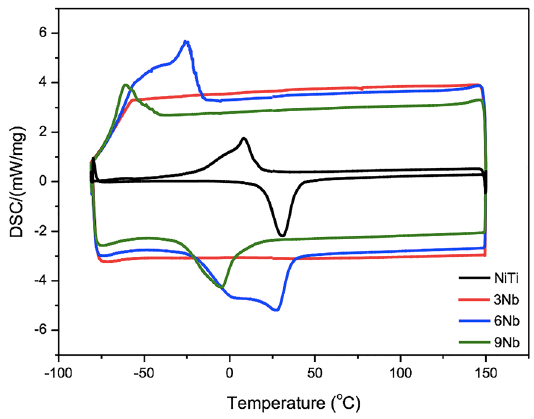
Figure 5. Resulting curves from the DSC analysis for the NiTi and NiTiNb alloys with different Nb contents.